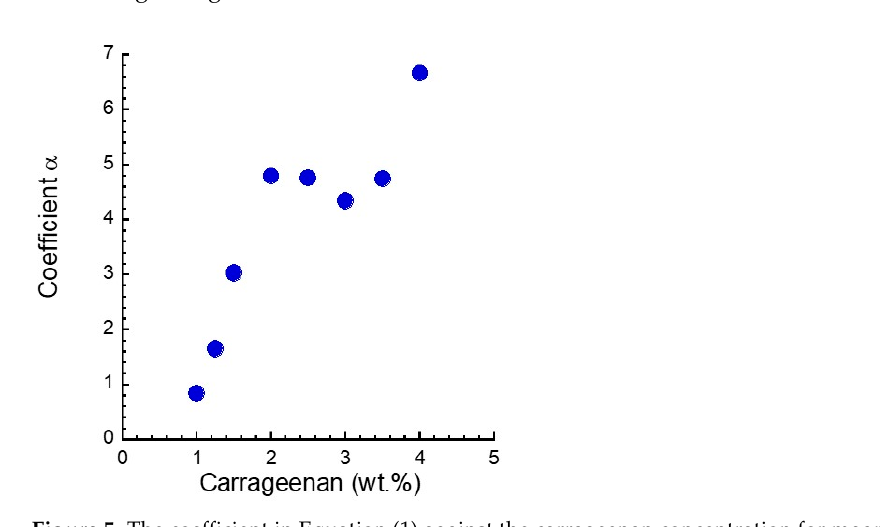
Figure 5. The coefficient in Equation (1) against the carrageenan concentration for magnetic gels with a concentration of 50 wt.%.